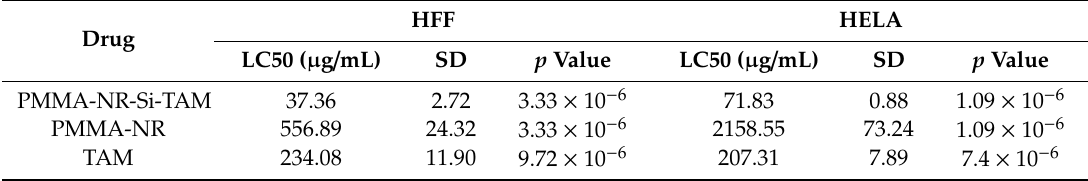
Table 2. HELA and HFF-1 treated with PMMA-NR-Si-TAM, PMMA-NR and free